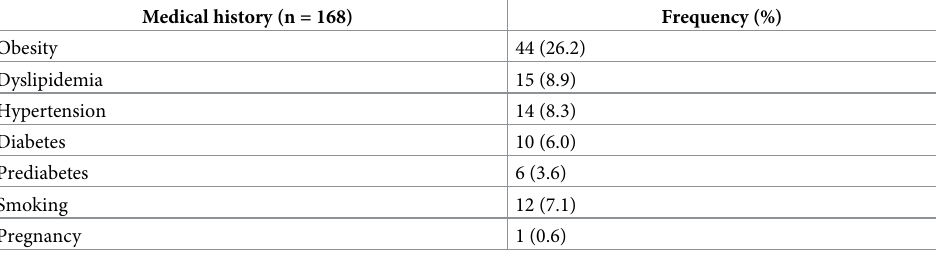
Table 1. Medical